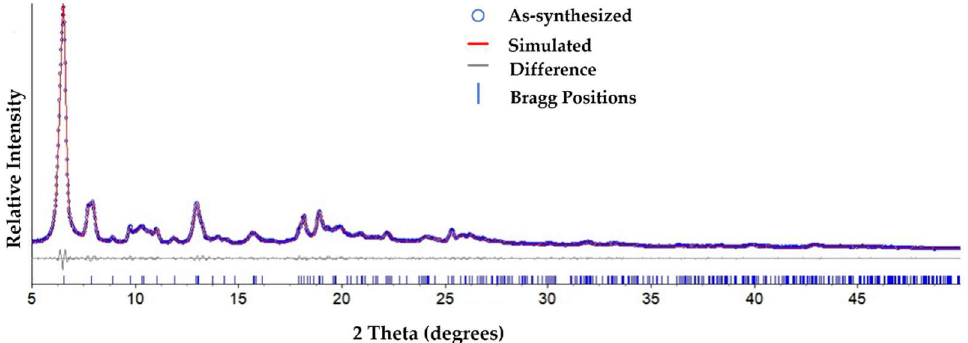
Figure 1. The Rietveld refinement XRD pattern of the as-synthesized SNNU-63.